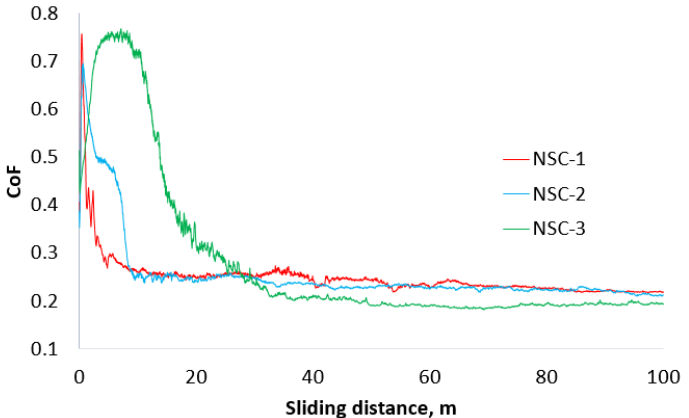
Figure A3. CoF curves for Hf-doped samples.